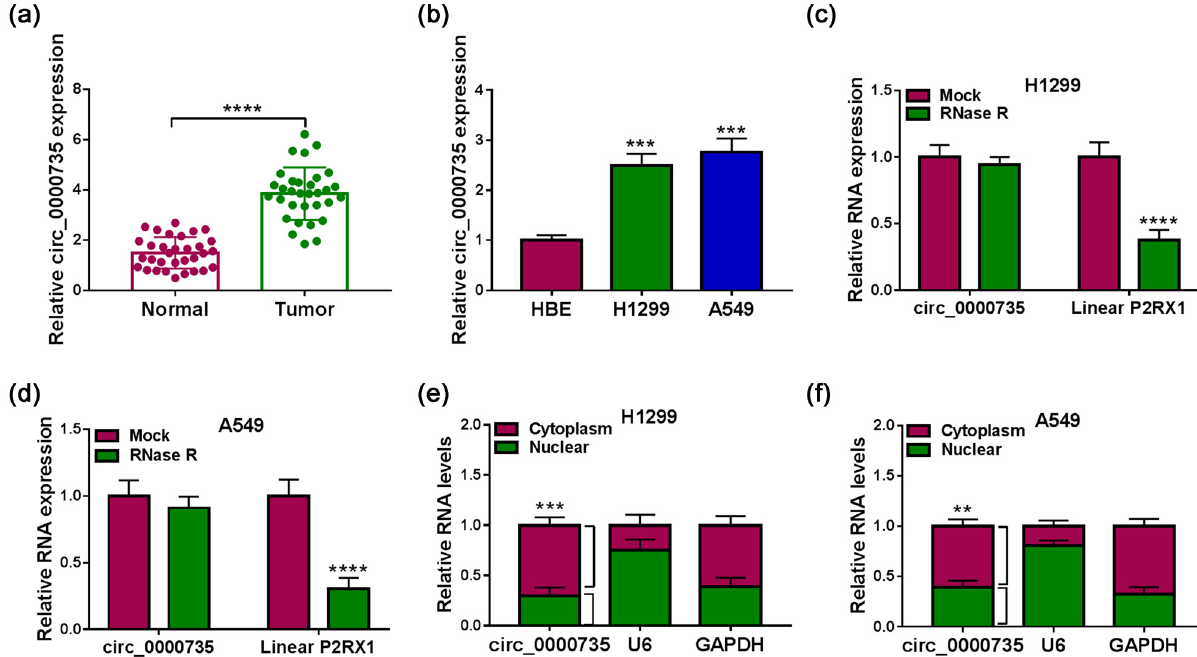
Figure 2: circ_0000735 was upregulated in NSCLC. ( a and b ) Relative expression of circ_0000735 in NSCLC tissues ( n = 32 ) and cells ( n = 3 ) was detected using RT - qPCR. ( c and d ) Relative expression of circ_0000735 in RNase R - digested NSCLC cell RNA was evaluated using RT - qPCR ( n = 3 ) . ( e and f ) After cell fractionation, the level of circ_0000735 in the nuclear and cytoplasmic fractions was analyzed using RT - qPCR ( n = 3 ) . U6 and GAPDH served as a positive control for nuclear and cytoplasmic fractions, respectively. *** P < 0.001 and **** P <